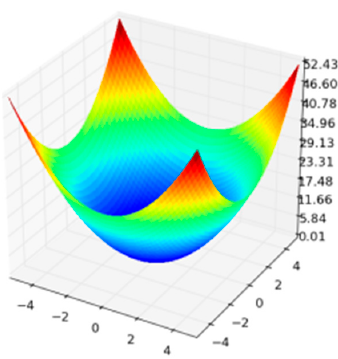
Figure 2. Sphere Function.